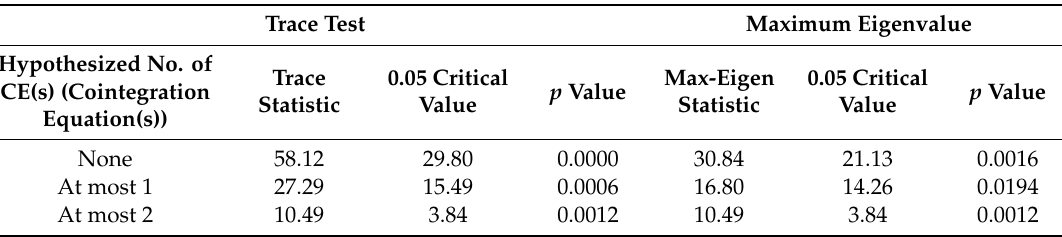
Table 3. The results of the Johansen cointegration test. Trace